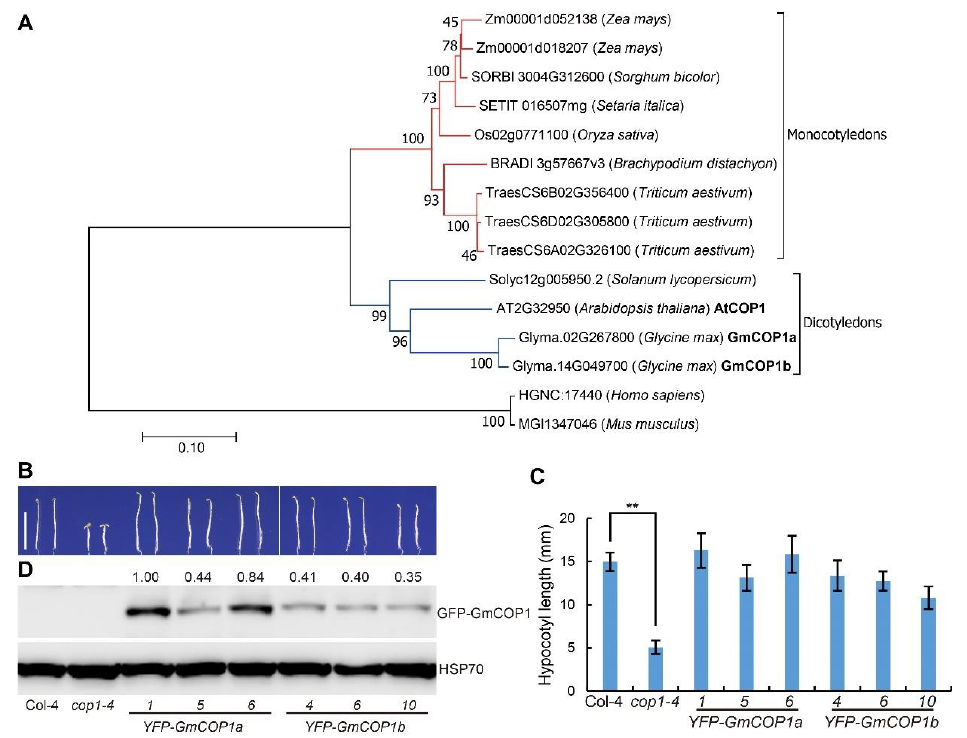
Figure 1. Ectopic expression of GmCOP1a or GmCOP1b in the Arabidopsis cop1 – 4 mutant. ( A ) Phylo- genetic analysis of COP1 proteins from indicated species. The sequences of COP1 homologous pro- teins were aligned by ClustalW to construct the neighbor-joining phylogenetic tree with 1000 boot- strap replicates by MEGA7. The two soybean homologous proteins, GmCOP1a (Glyma.02G267800) and GmCOP1b (Glyma.14G049700), as well as AtCOP1, are highlighted in bold. The red lines indi- cate the monocotyledons; the blue lines indicate dicotyledons. ( B ) Hypocotyl phenotypes of the YFP-GmCOP1a and YFP-GmCOP1b transgenic lines in the cop1 – 4 mutant background. Seedlings were grown in darkness for 5 days, scale bar = 1 cm. ( C ) Statistical analysis of hypocotyl lengths in ( B ). The values represent the means ± SD ( n ≥ 15). The significant difference was determined by Studen t’s t -test (** p < 0.01). ( D ) Immunoblot shows the expression levels of YFP-GmCOP1a or YFP- GmCOP1b proteins in the indicated lines using the anti-GFP antibody. HSP70 was used as a refer- ence protein. The numbers at the top indicate the relative abundance of transgenic proteins, which was calculated by the formula GFP/HSP70. 2.2. The Expression Profiles of GmCOP1a and GmCOP1b Next, we tested the transcript levels of GmCOP1s in different tissues. The result showed that both GmCOP1a and GmCOP1b have a higher expression level in cotyledon, unifoliolate leaf, and trifoliolate leaf, followed by the stem, apex, but a lower level in the root (Figure 2), implying that GmCOP1s majorly function in the light-perceiving aerial tissues. The expression patterns of GmCOP1a and GmCOP1b are very similar, suggesting that they have redundant functions in soybean. The overall expression levels of GmCOP1b in different tissues were moderately higher than that of GmCOP1a (Figure 2), implying that the GmCOP1b gene may play a relatively robust role in regulating soybean morpho- genesis.